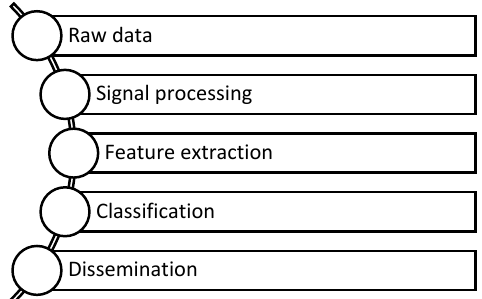
Figure 7. Flowchart of the cyber part.